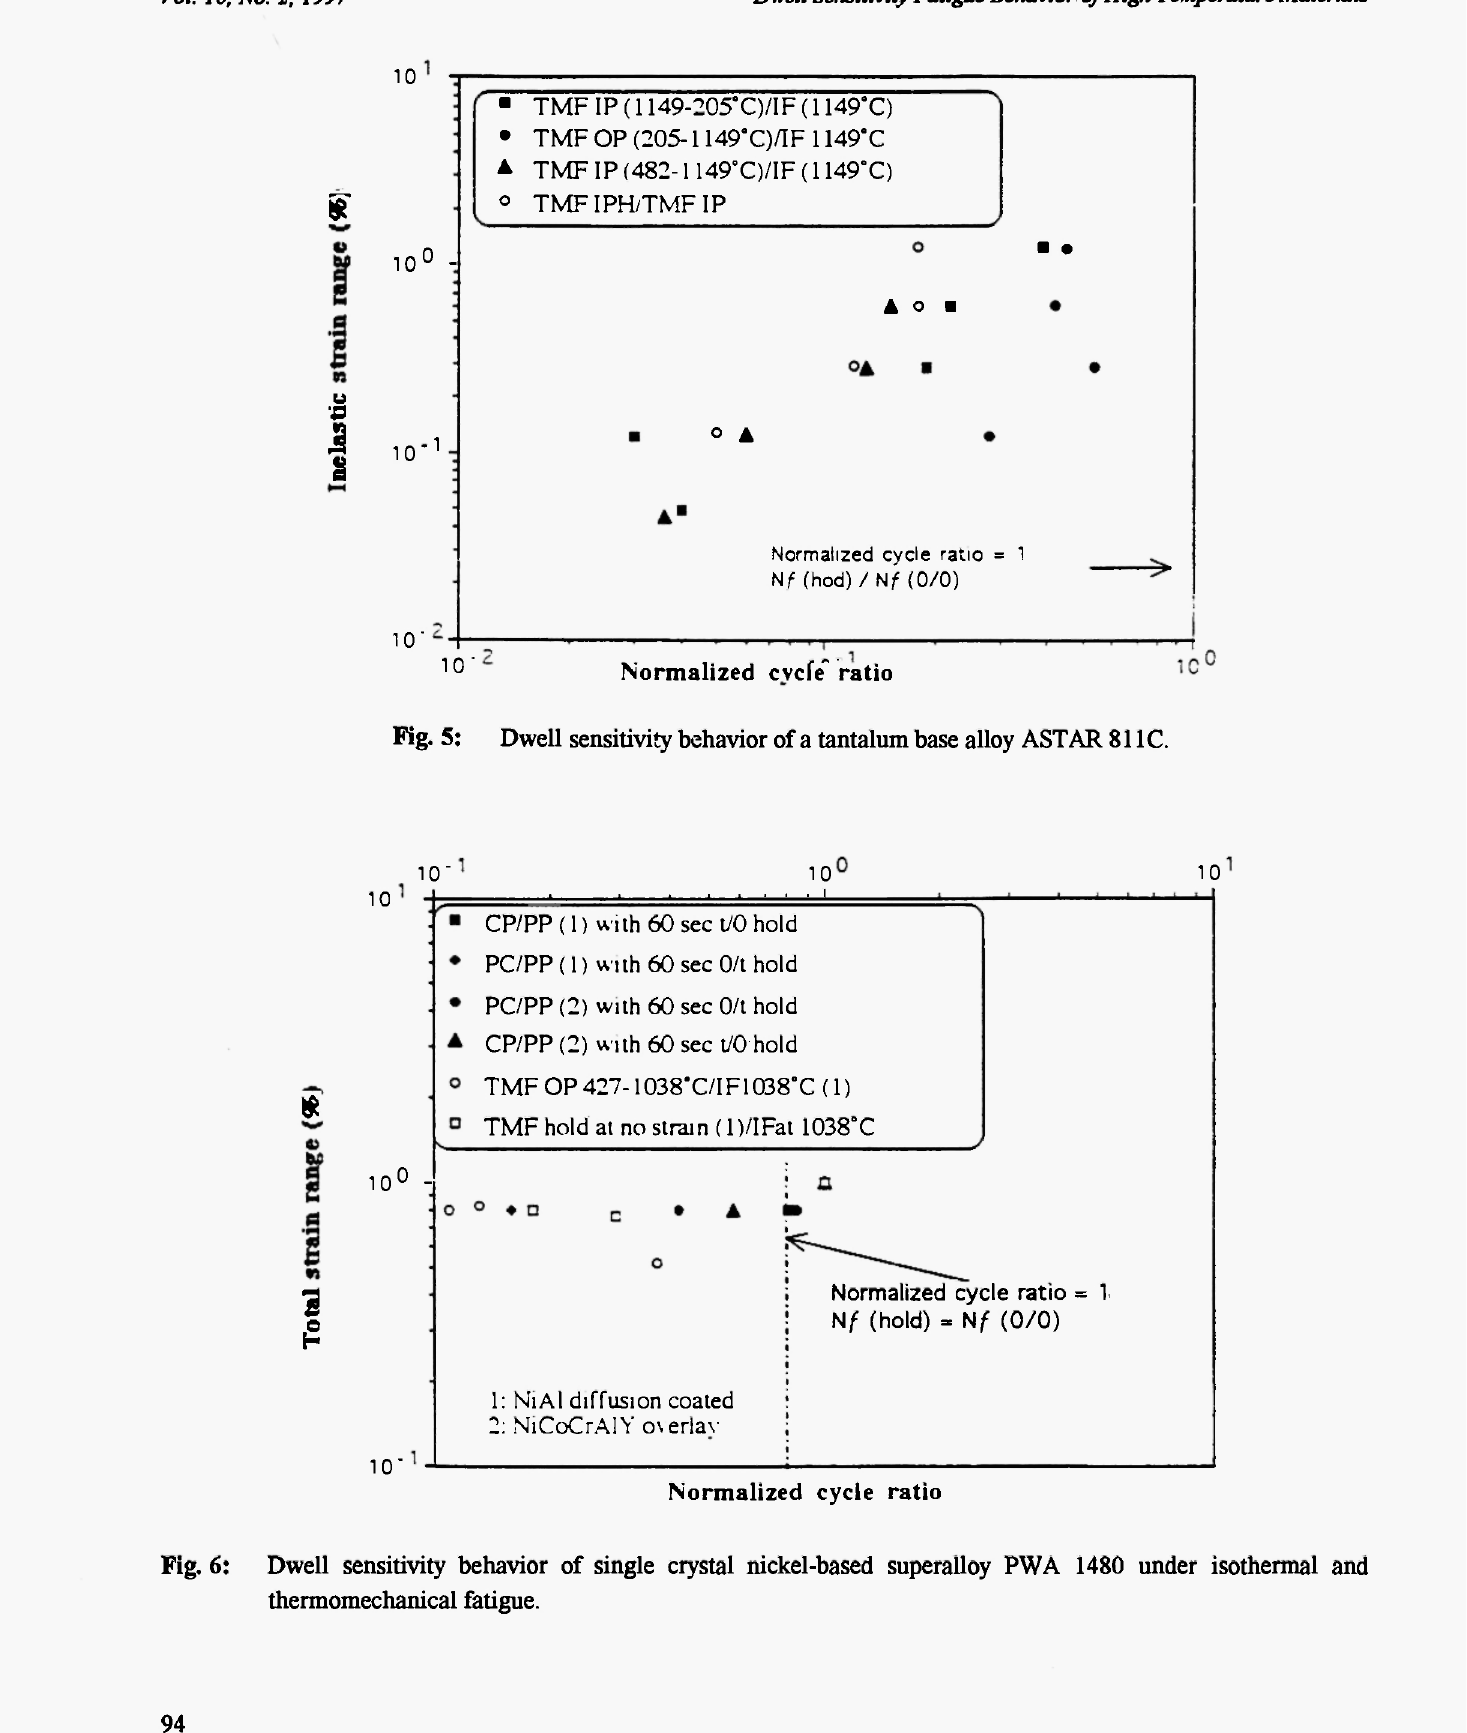
Fig. 6: Dwell sensitivity behavior of single crystal nickel-based superalloy PWA 1480 under isothermal and thermomechanical